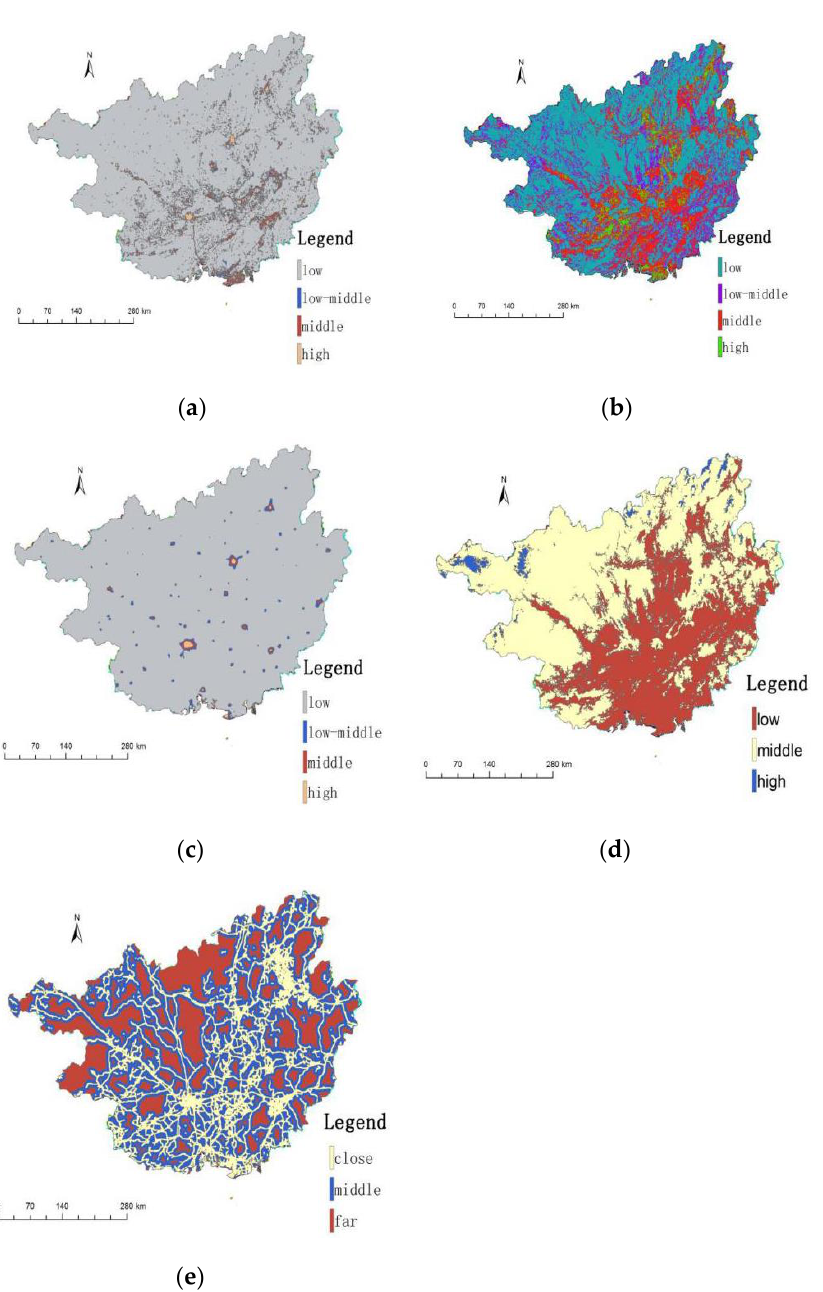
Figure 3. Location of Guangxi ( a ) and the spatial distribution map of land use types ( b ) in Guangxi 2010.